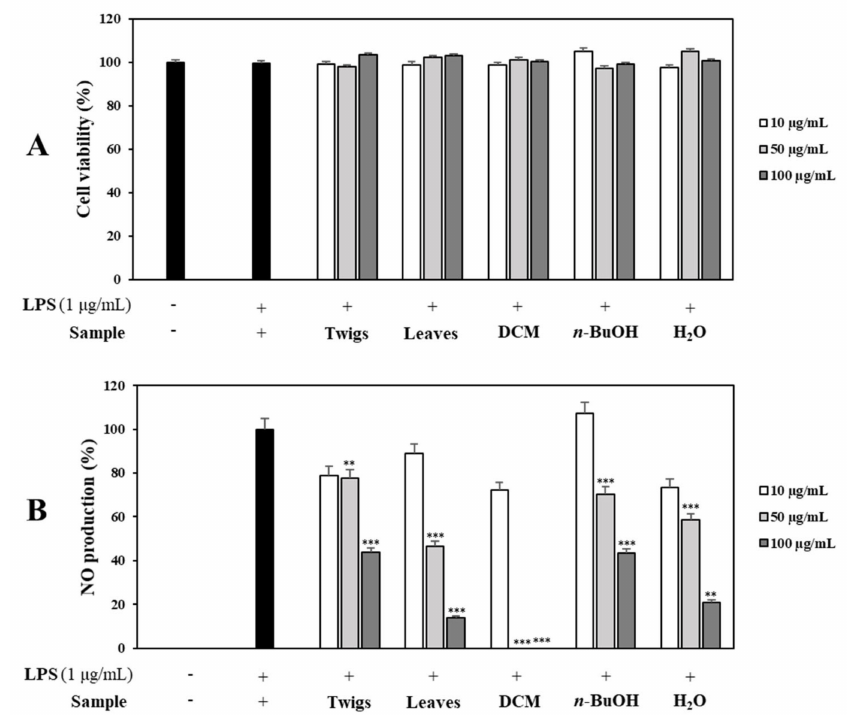
Figure 1. Effects of the total extract and fractions of aerial parts of P. macrophyllus on cell viability and NO production. ( A ) RAW 264.7 cells were cultured in the presence of the total extract and extraction fractions (10, 50, and 100 µ g/mL) for 1 h and induced with LPS (1 µ g/mL) for 16 h. Cell viability and NO production were measured using MTT assay and Griess reagent, respectively. ( B ) Nitrite concentrations of untreated and LPS-treated controls, respectively. Each experiment was performed in triplicates. The data are represented as mean ± SD. ** p < 0.01, *** p < 0.001 vs. LPS-treated